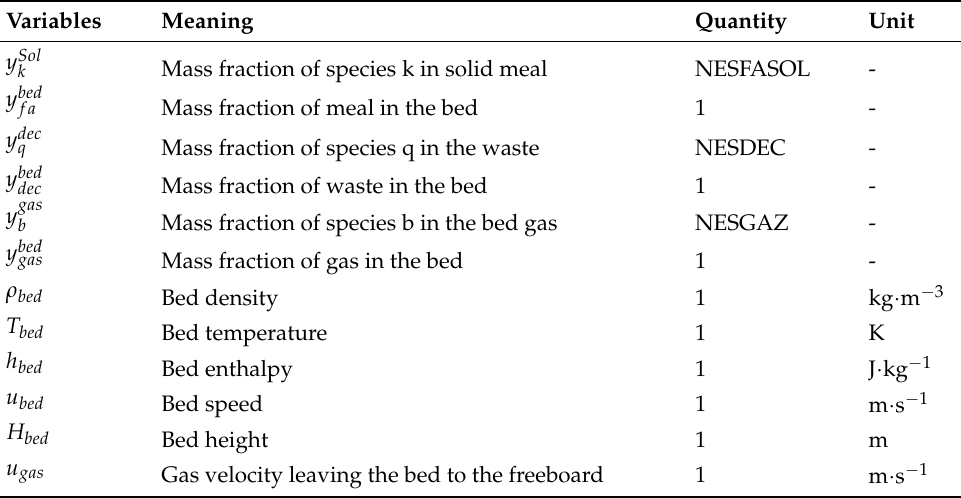
Table 2. Variables of the 1D model of the bed of